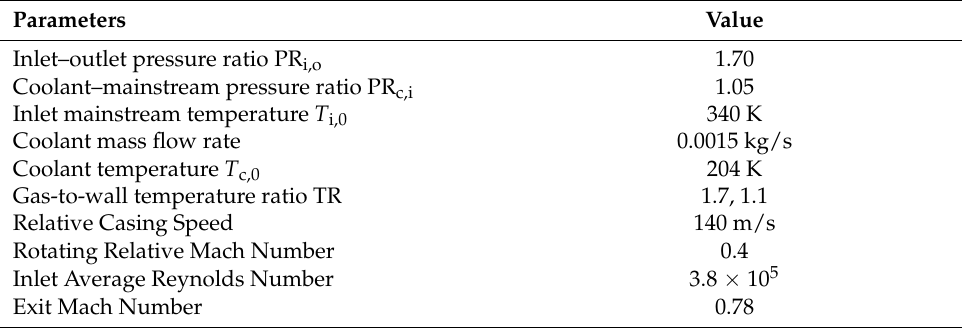
Figure 1. CFD simulation domain and mesh details. Table 1. Boundary conditions used in the present